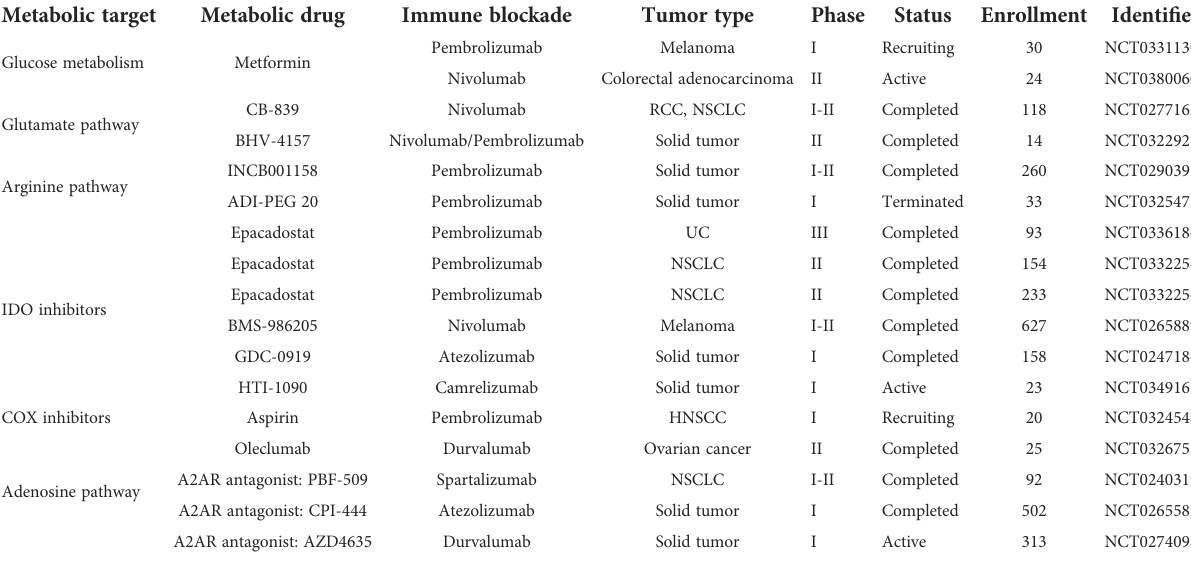
TABLE 4 Ongoing clinical trials combining metabolic interventions and immune checkpoint